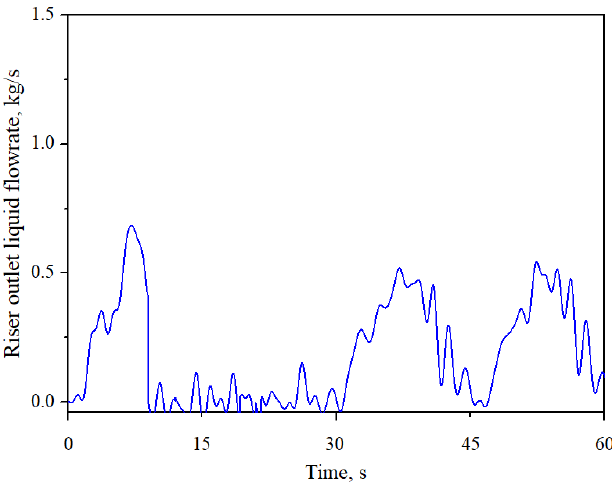
Figure 9. Experimental profile of slug production during choking-induced slug flow ( U GS = 0.08 m/s and U LS = 0.09 m/s).